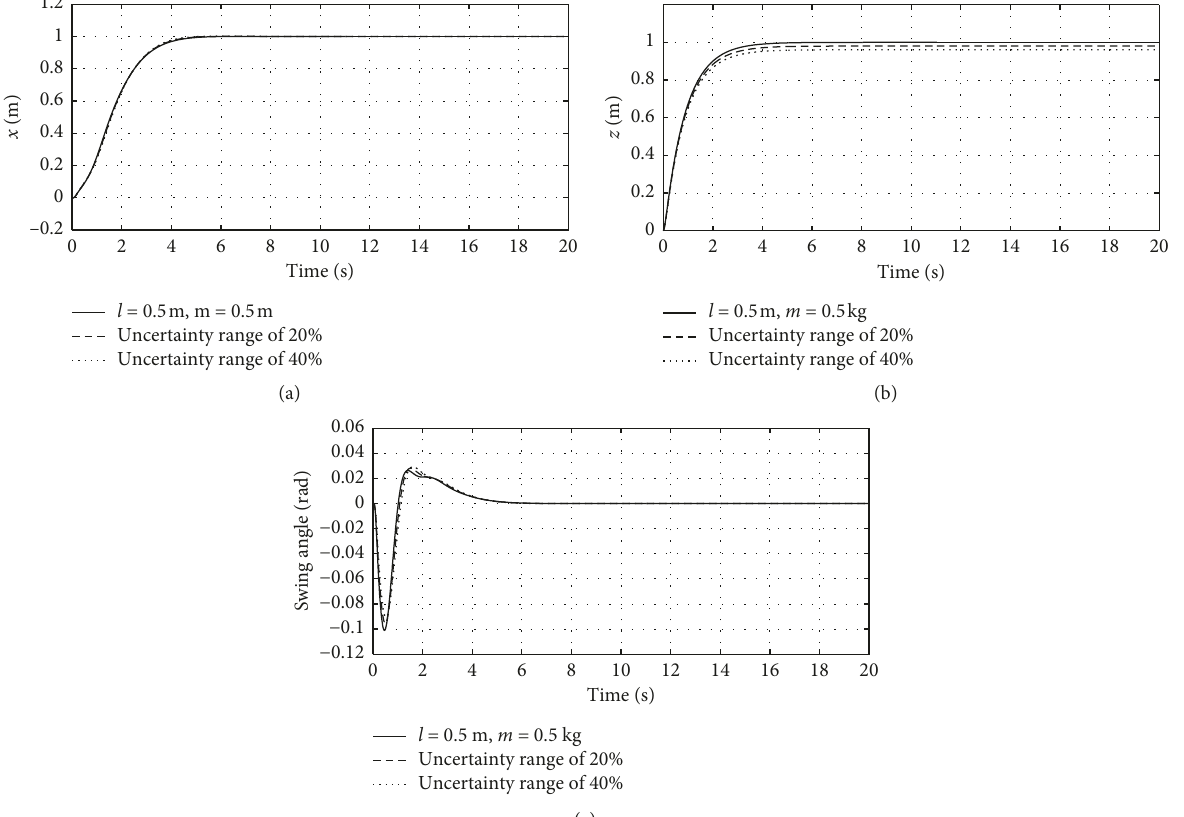
Figure 10: Quadrotor positions along the X - and Z -axis, and pendulum swing angle–responses for l � 0.5 m and m � 0.5kg, and for parameter perturbation with the range of 20% and